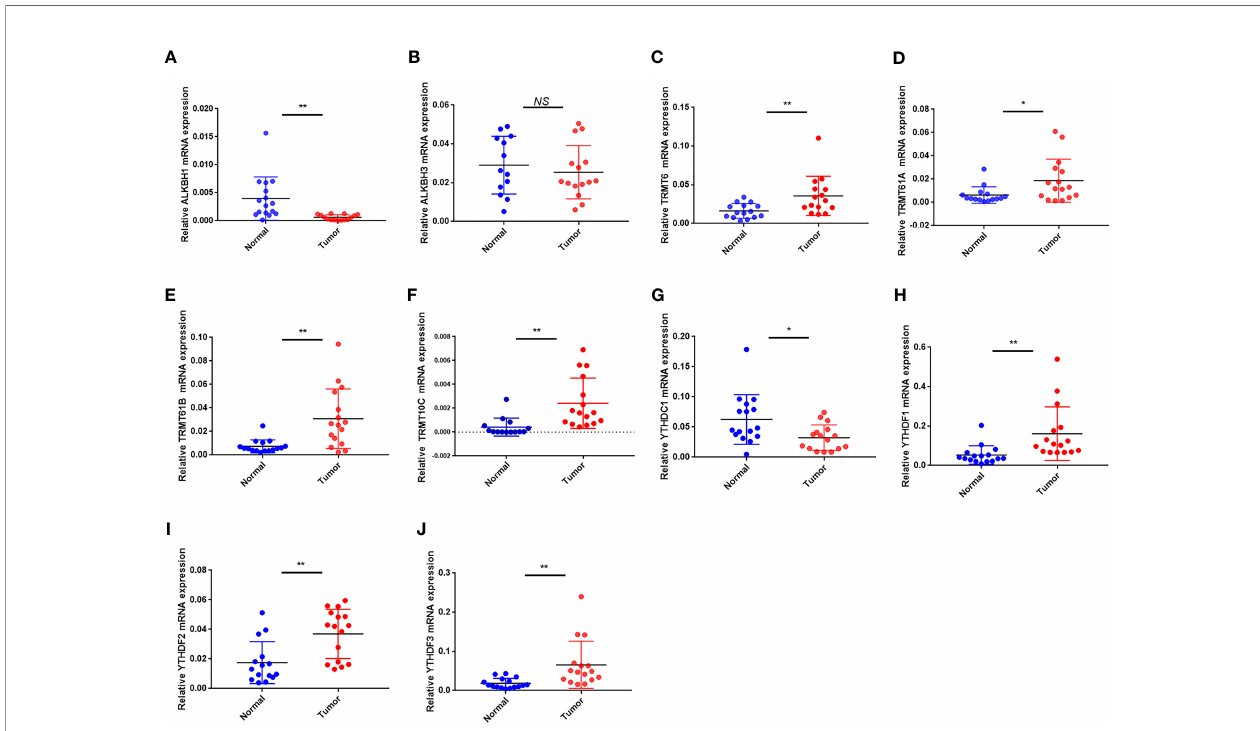
FIGURE 11 | The mRNA expression of the 10 m1A regulators in tumor and normal samples. (A – J) The mRNA expression of (A) ALKBH1, (B) ALKBH3, (C) TRMT6, (D) TRMT61A, (E) TRMT61B, (F) TRMT10C, (G) YTHDC1, (H) YTHDF1, (I) YTHDF2 and (J) YTHDF3. *P < 0.05; **P < 0.01; ns, not signi fi